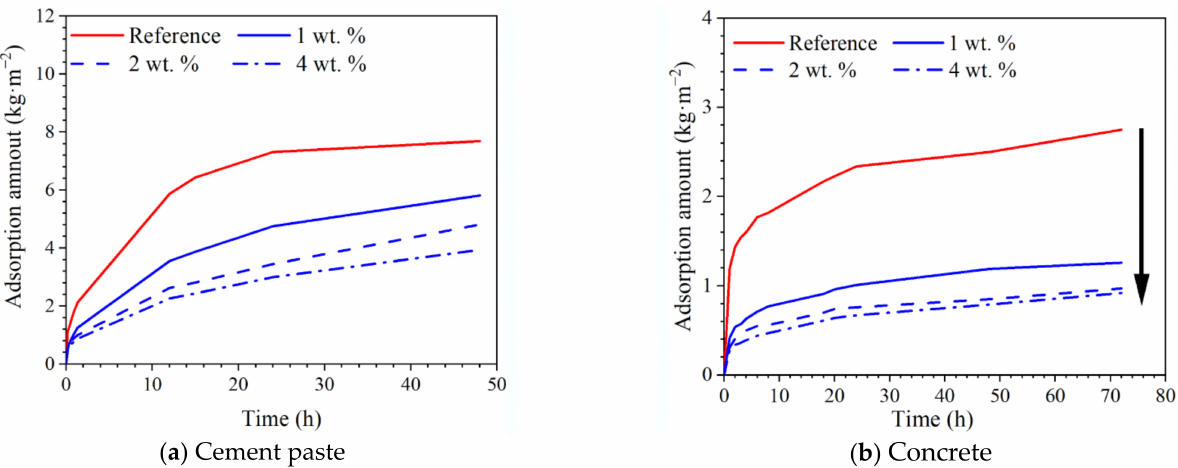
Figure 6. Capillary water absorption amount of both cement paste and concrete with different dosages of hydrophobic functional corrosion inhibitor at 28 d of curing.